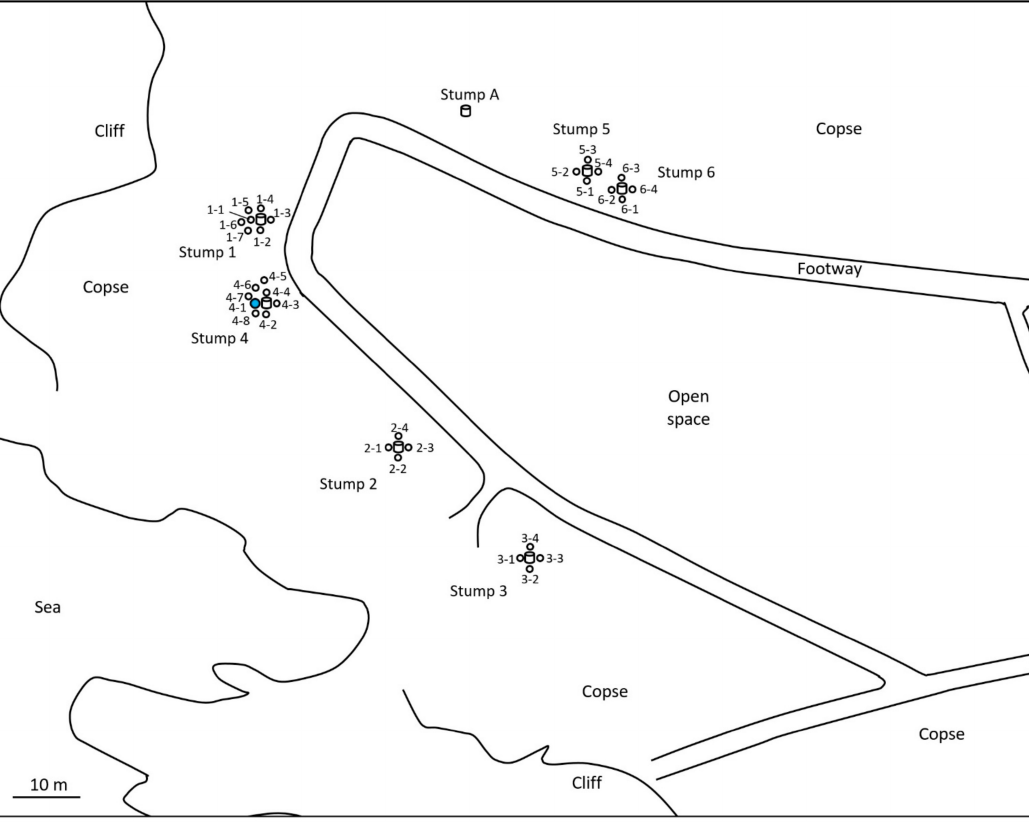
Figure 2. Location of monitoring stations (open circles) in Isogi Park. Twelve stations (1-1, 1-2, 1-3, 1-4, 2-1, 2-2, 2-3, 2-4, 3-1, 3-2, 3-3, and 3-4) were installed around stumps 1, 2, and 3 in June 2016. Four stations (4-1, 4-2, 4-3, and 4-4) were installed around stump 4 in July 2016. Three stations (1-5, 1-6, and 1-7) and four stations (4-5, 4-6, 4-7, and 4-8) were additionally installed around stumps 1 and 4, respectively, in December 2016. Eight stations (5-1, 5-2, 5-3, 5-4, 6-1, 6-2, 6-3, and 6-4) were installed around stumps 5 and 6 in March 2017. All stations were installed in-ground. Station 4-1, around which discontinuous soil treatment was carried out, is highlighted in